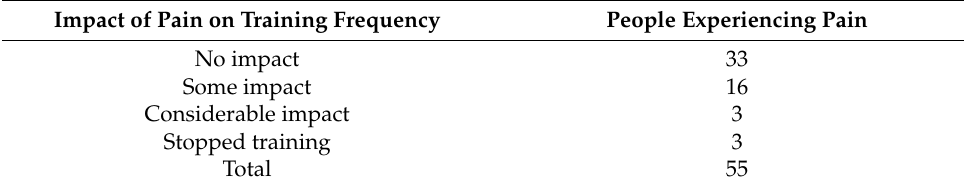
Table 4. Impact of pain on training frequency.